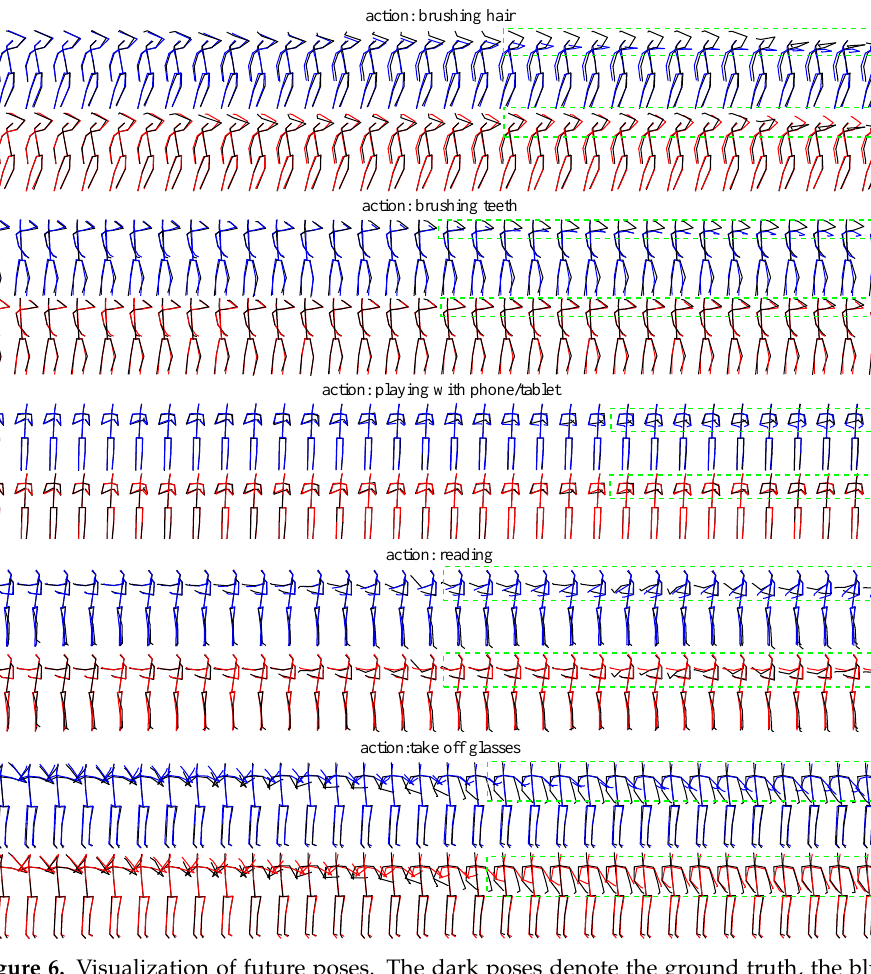
Figure 6. Visualization of future poses. The dark poses denote the ground truth, the blue poses denote the predictions of TrajectoryCNN [8], and the red poses denote the predictions of our